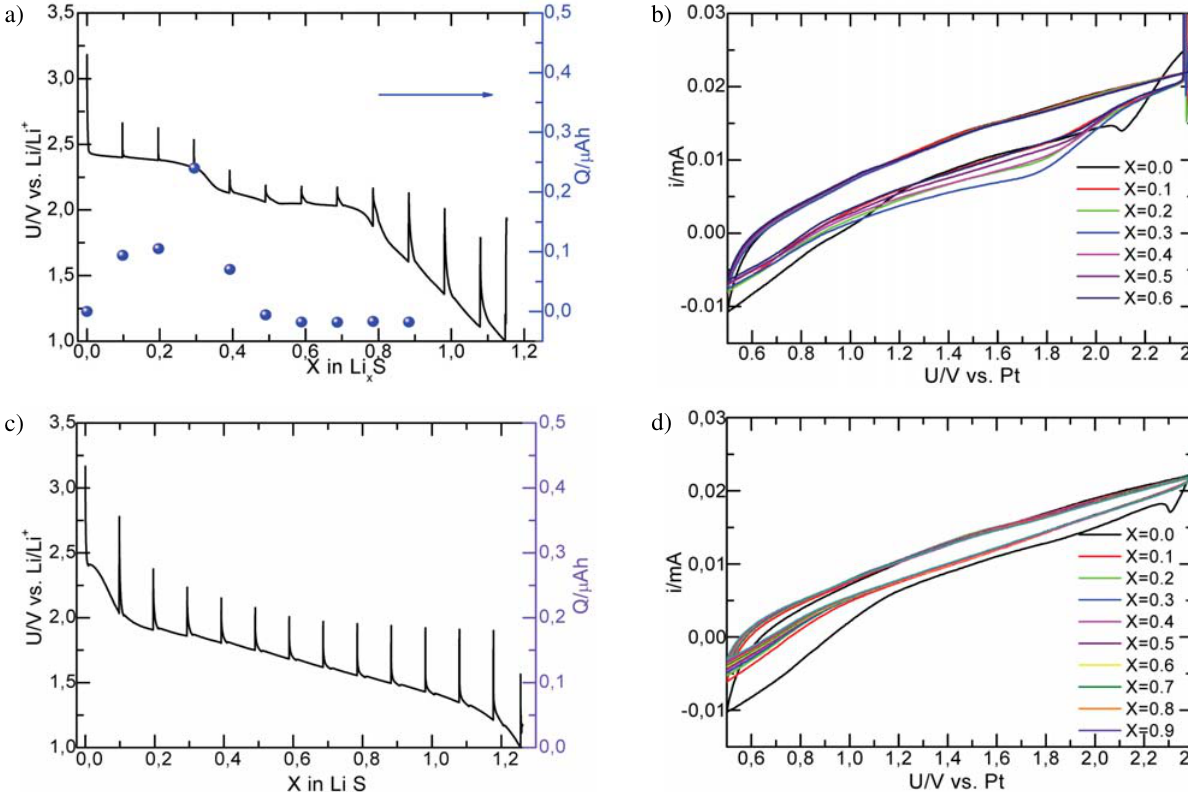
Figure 7. a) Electrochemical behaviour during the first reduction of carbon/S composite and cumulative charge obtained by the integration of indi- vidual CV scans. b) Corresponding CV scans measured for each Δ x = 0.1 change of composition in Li first reduction of PAN/S composite. d) Corresponding CV scans measured for each Δ x = 0.1 change of